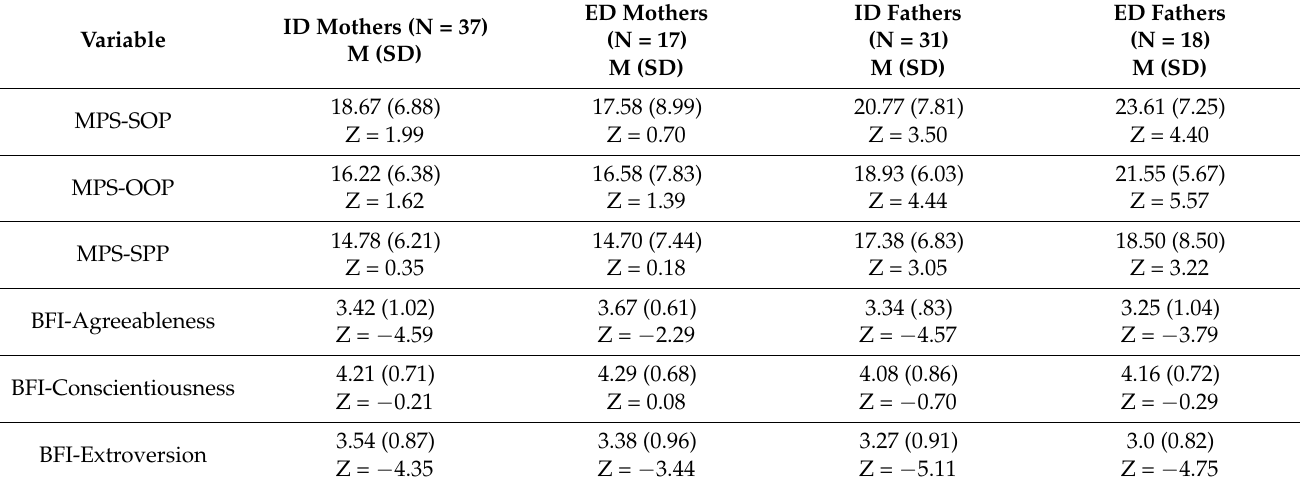
Table 2. Descriptive of parent’s self-reported perfectionism and personality (MPS-S, BFI-10) and parent’s reported personality of the children (HiPIC—five dimensions) 1